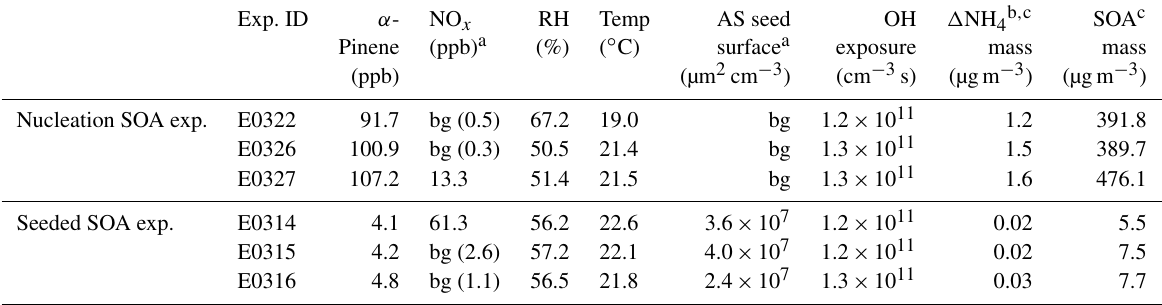
Table 1. Initial experimental parameters and results in two sets of experiments. Exp. ID α - NO x RH Temp AS seed OH (cid:49) NH 4b , c SOA c Pinene (ppb) a (%) ( ◦ C) surface a exposure mass mass (ppb) (µm 2 cm − 3 ) (cm − 3 s) (µgm − 3 ) (µgm − 3 ) Nucleation SOA exp. E0322 91.7 bg (0.5) 67.2